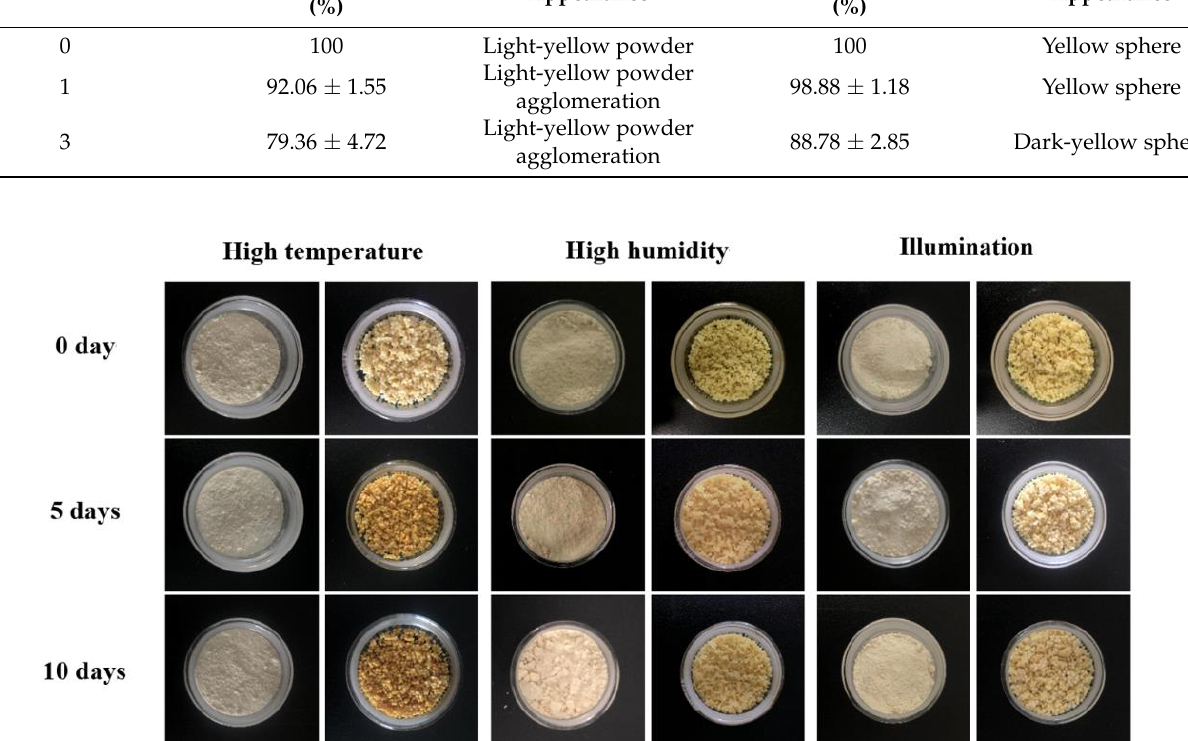
Figure 7. The change of free naringin and microspheres under different conditions on days 0, 5, and 10.